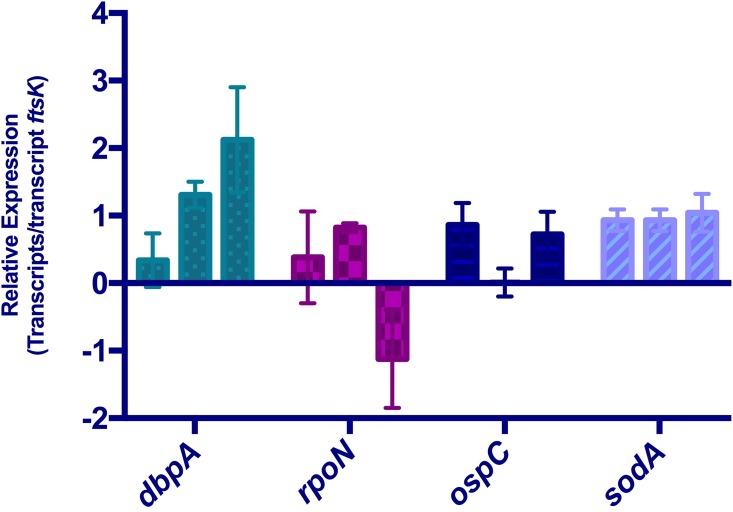
Quantitative RT-PCR analyses of select transcripts.Results for each transcript were compared with results for ftsK transcript of that culture. For each gene tested, bars from left to right are relative abundance during early-exponential, mid-exponential, and stationary phases of growth.